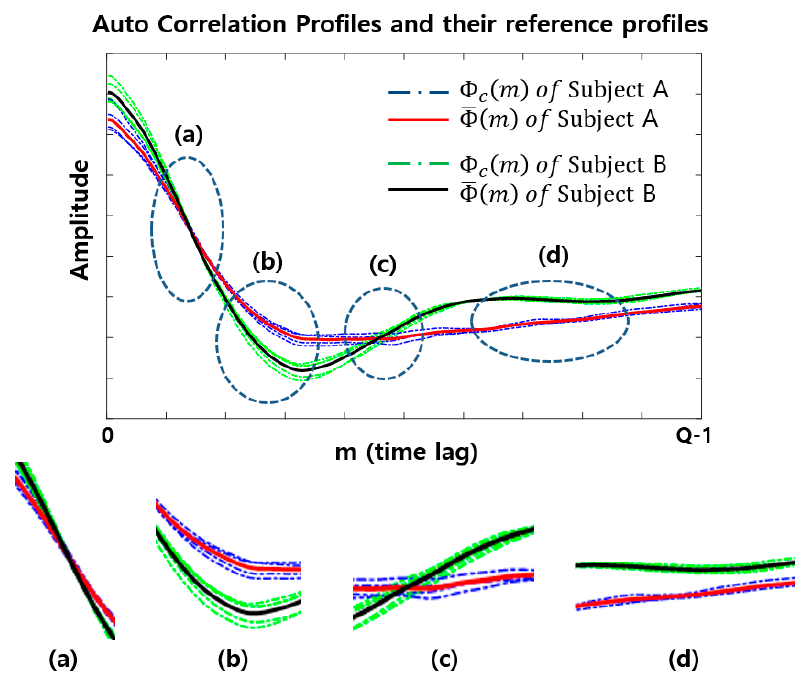
Figure 5. An example of a set of ACPs, displayed together within the same time period of Q , for two different subjects (subject A and subject B) when C = 5. ( a – d ) illustrate the differences in amplitude and angle patterns of ACPlet generated when the ACPs are segmented into six ACPlets, even though the two subjects have a very similar ACP shape.